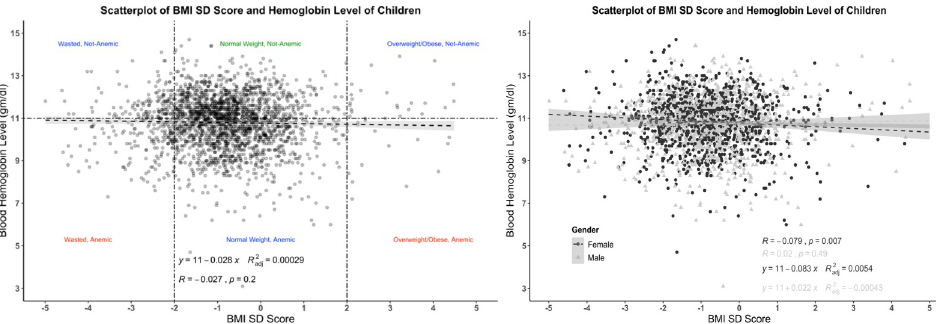
Fig 4. Association (linear) of BMI and blood hemoglobin level of children (n = 2373). Marginal density is shown for the three BMI categories (dotted vertical lines). Anemia is indicated using the cut-off < 11 g/dl (dotted horizontal line).